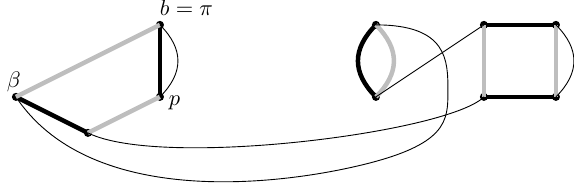
Figure 7 . The graph G 00 = A 00 [ B 00 with P 00